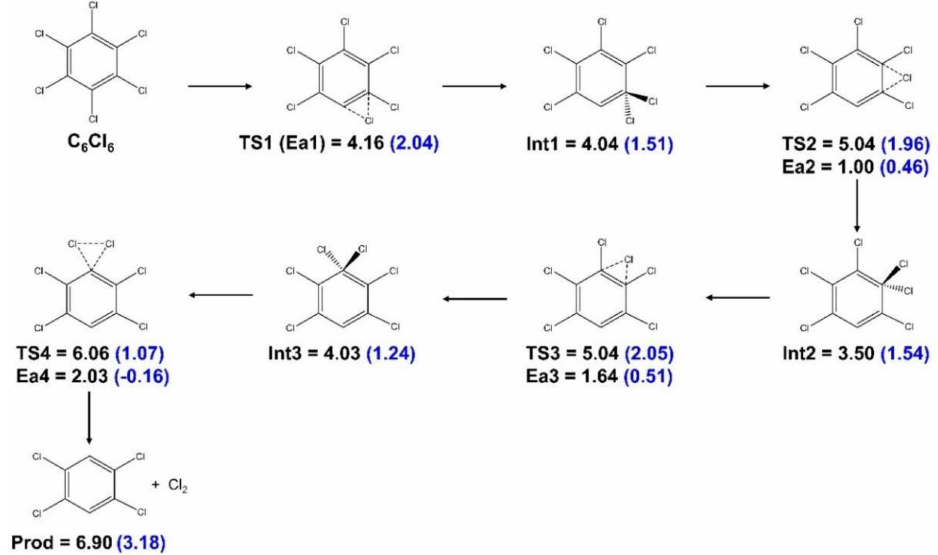
Figure 4. Detachment of Cl 2 and Cl 2 − from para sites in C 6 Cl 6 . Energies in eV. The values in parenthesis are for the anionic system.